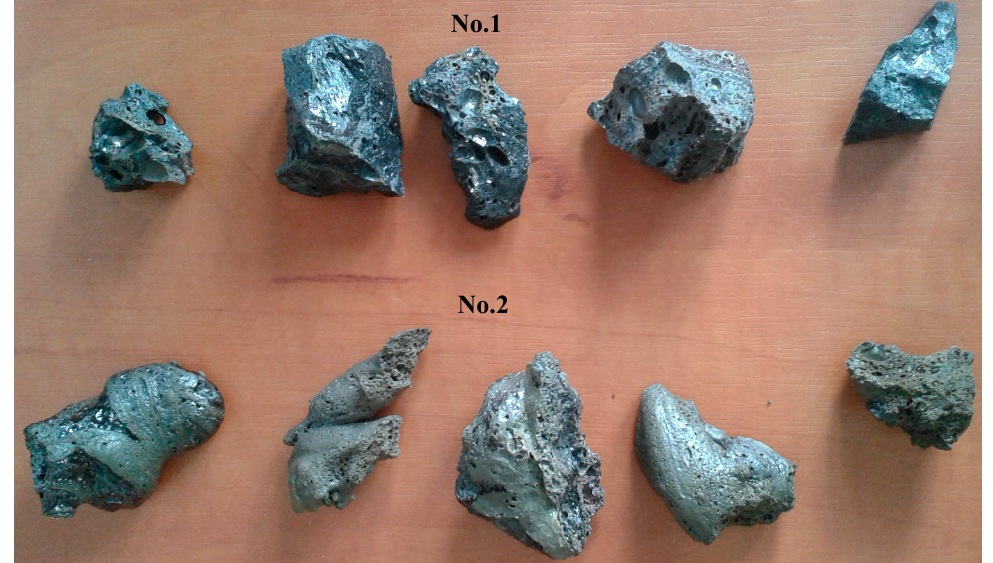
Figure 5. Picture presenting crushed vitrified lignite fly ash samples no. 1 and no.2. Color of the sample no. 1 is black and the sample no. 2 is rather gray/green inside, and on top slightly